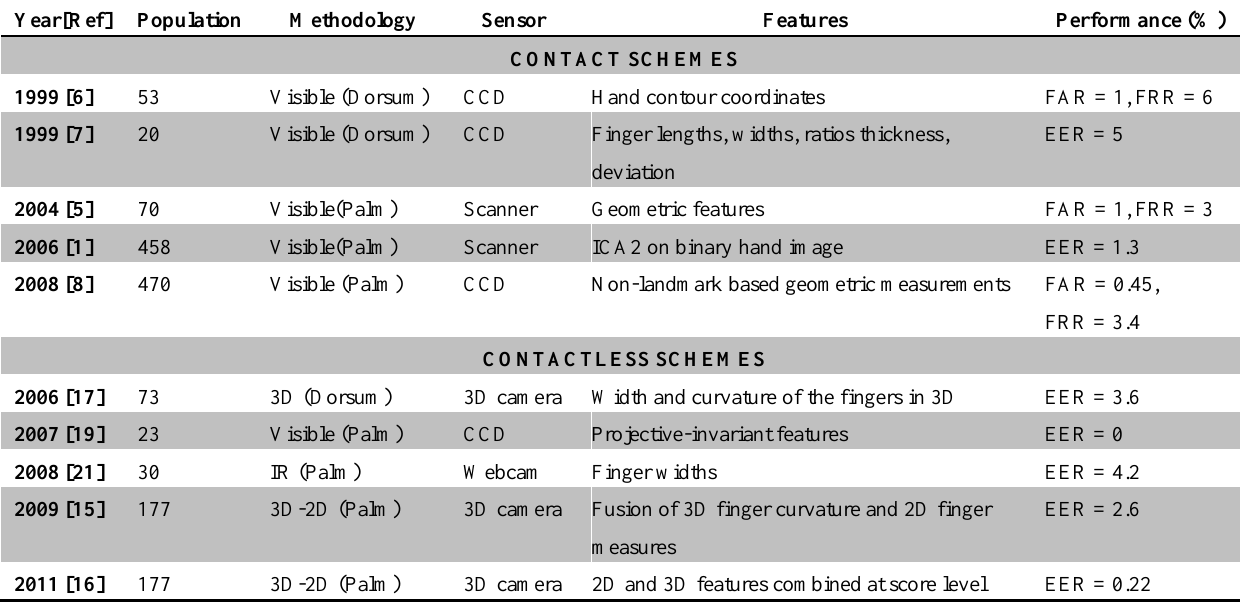
Table 1. Some examples of hand-shape based biometric